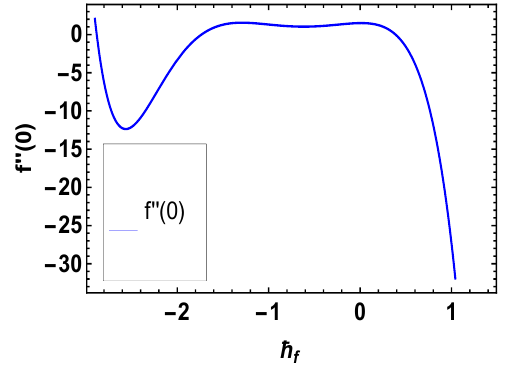
Figure 2. Outcomes of ¯ h f for f (cid:48)(cid:48) ( 0 ) .